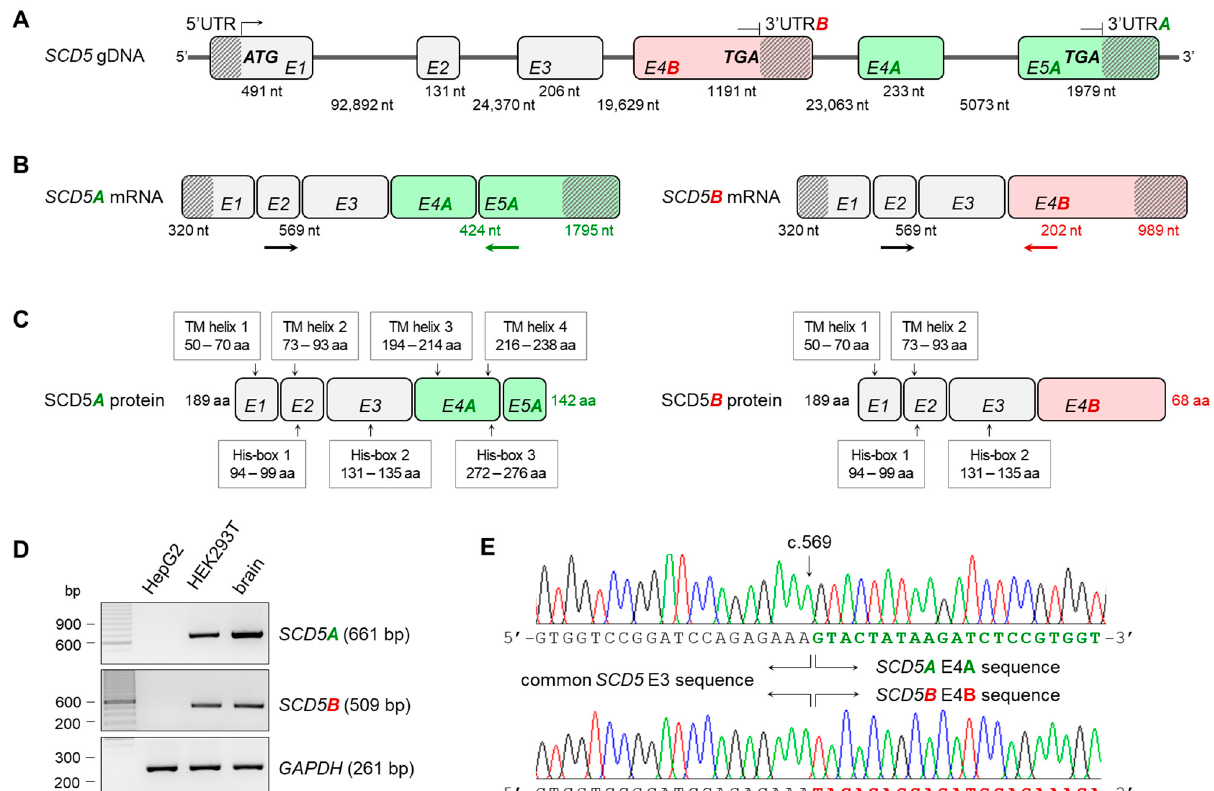
Figure 1. Transcript variants of human SCD5 gene. Schematic gene ( A ), mRNA ( B ) and protein ( C ) structure of human SCD5A and B transcript variants. Exons are numbered and marked with rectangles. Introns are depicted with straight lines and UTRs with diagonally lined rectangles. The start and stop codons, and the length of introns and exons are also indicated. SCD5A - and SCD5B -specific and shared exons are shown in green, red and gray, respectively. The position of the putative TM domains and His-boxes in the protein are also marked. Verification of SCD5A - and SCD5B -specific splicing events by RT-PCR ( D ) and direct sequencing ( E ). RT-PCR primers used to verify A- and B-specific splicing events are indicated by arrows, SCD5A - and SCD5B -specific and shared primers are shown in green, red and black, respectively. The agarose gel images represent typical results of three independent experiments. The electropherograms show the AS hotspot of the two transcript variants indicating the starting point of the di ff erent 3 ′ ends. (aa: amino acid; nt: nucleotide; TM helix: transmembrane helix; His-box: histidine containing sequence).